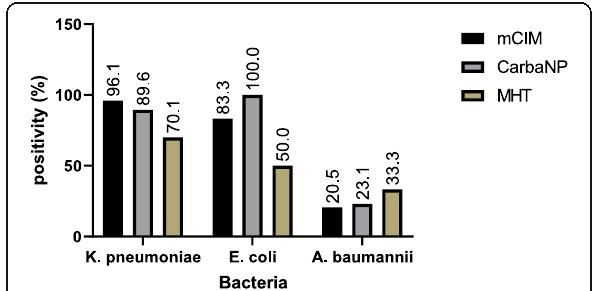
Fig. 1 The positivity of the different phenotypic test to detection of carbapenemase production by bacteria. mCIM modified carbapenem inactivation method, MHT modified Hodge